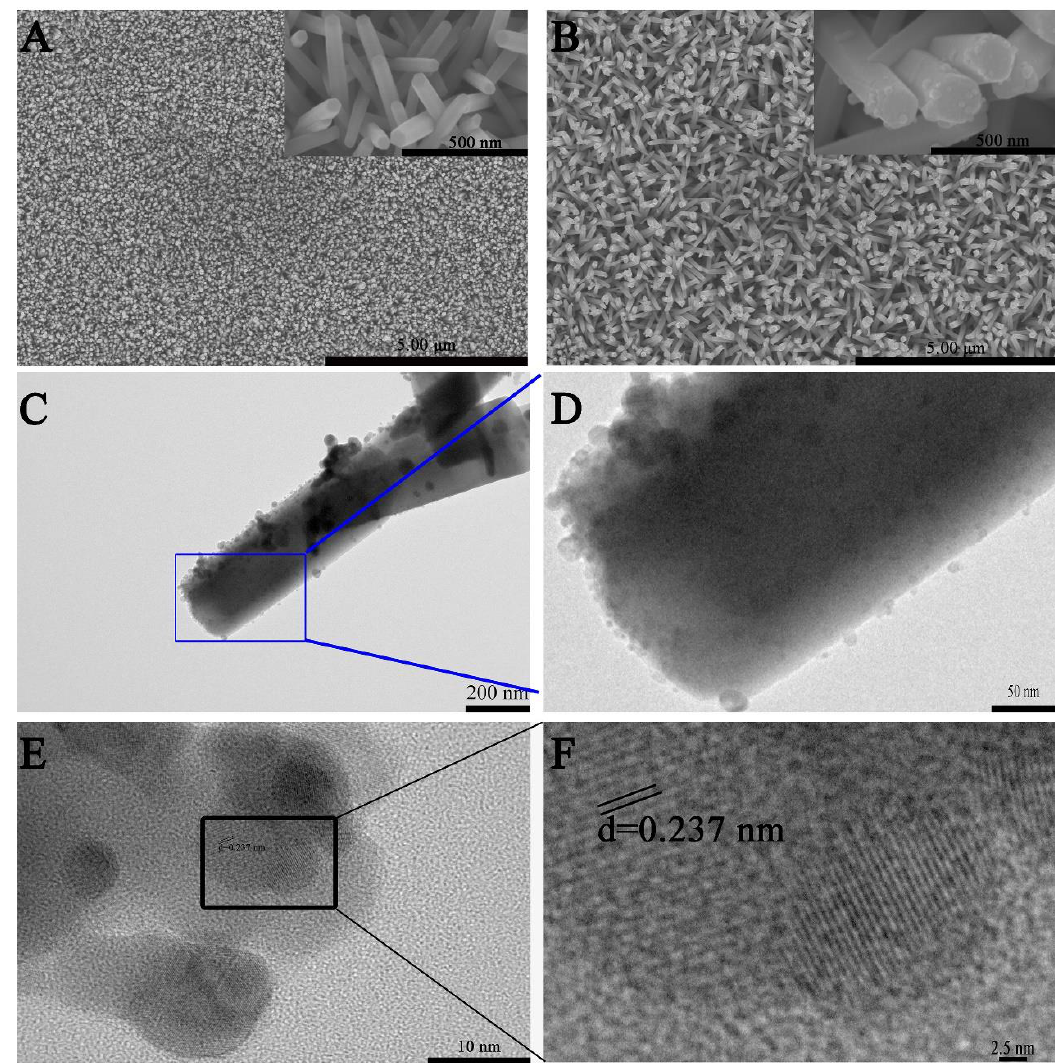
Figure 1. ( A ) SEM image of the pure ZnO nanorod and ( B ) Ag–ZnO nanorod array; ( C ) TEM image of the Ag–ZnO nanorod array and ( D ) partial enlarged view of ( C , E ) HRTEM image of the Ag–ZnO nanorod array and ( F ) partial enlarged view of ( E ).